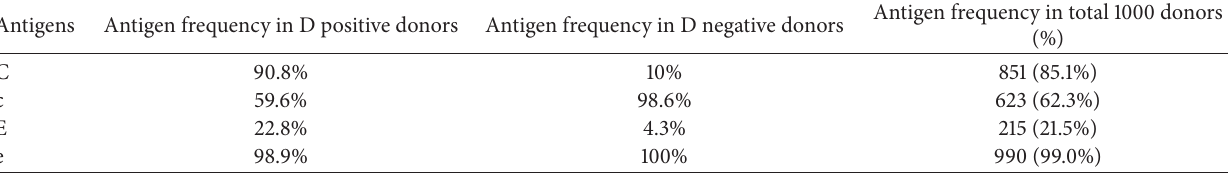
Table 2: Comparison of antigen frequency of Rh subgroup antigens in D positive and D negative donors.